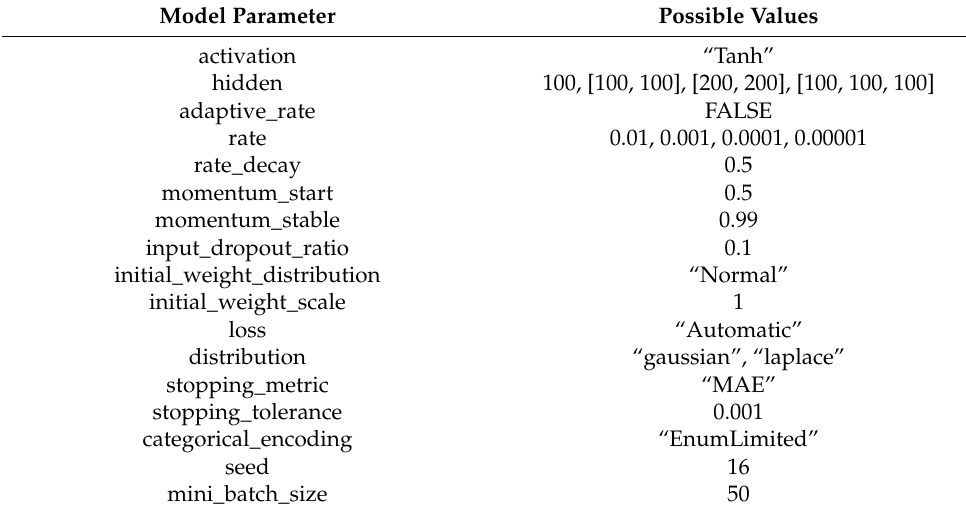
Table 12. Tuning Parameters for Deep Learning Severity